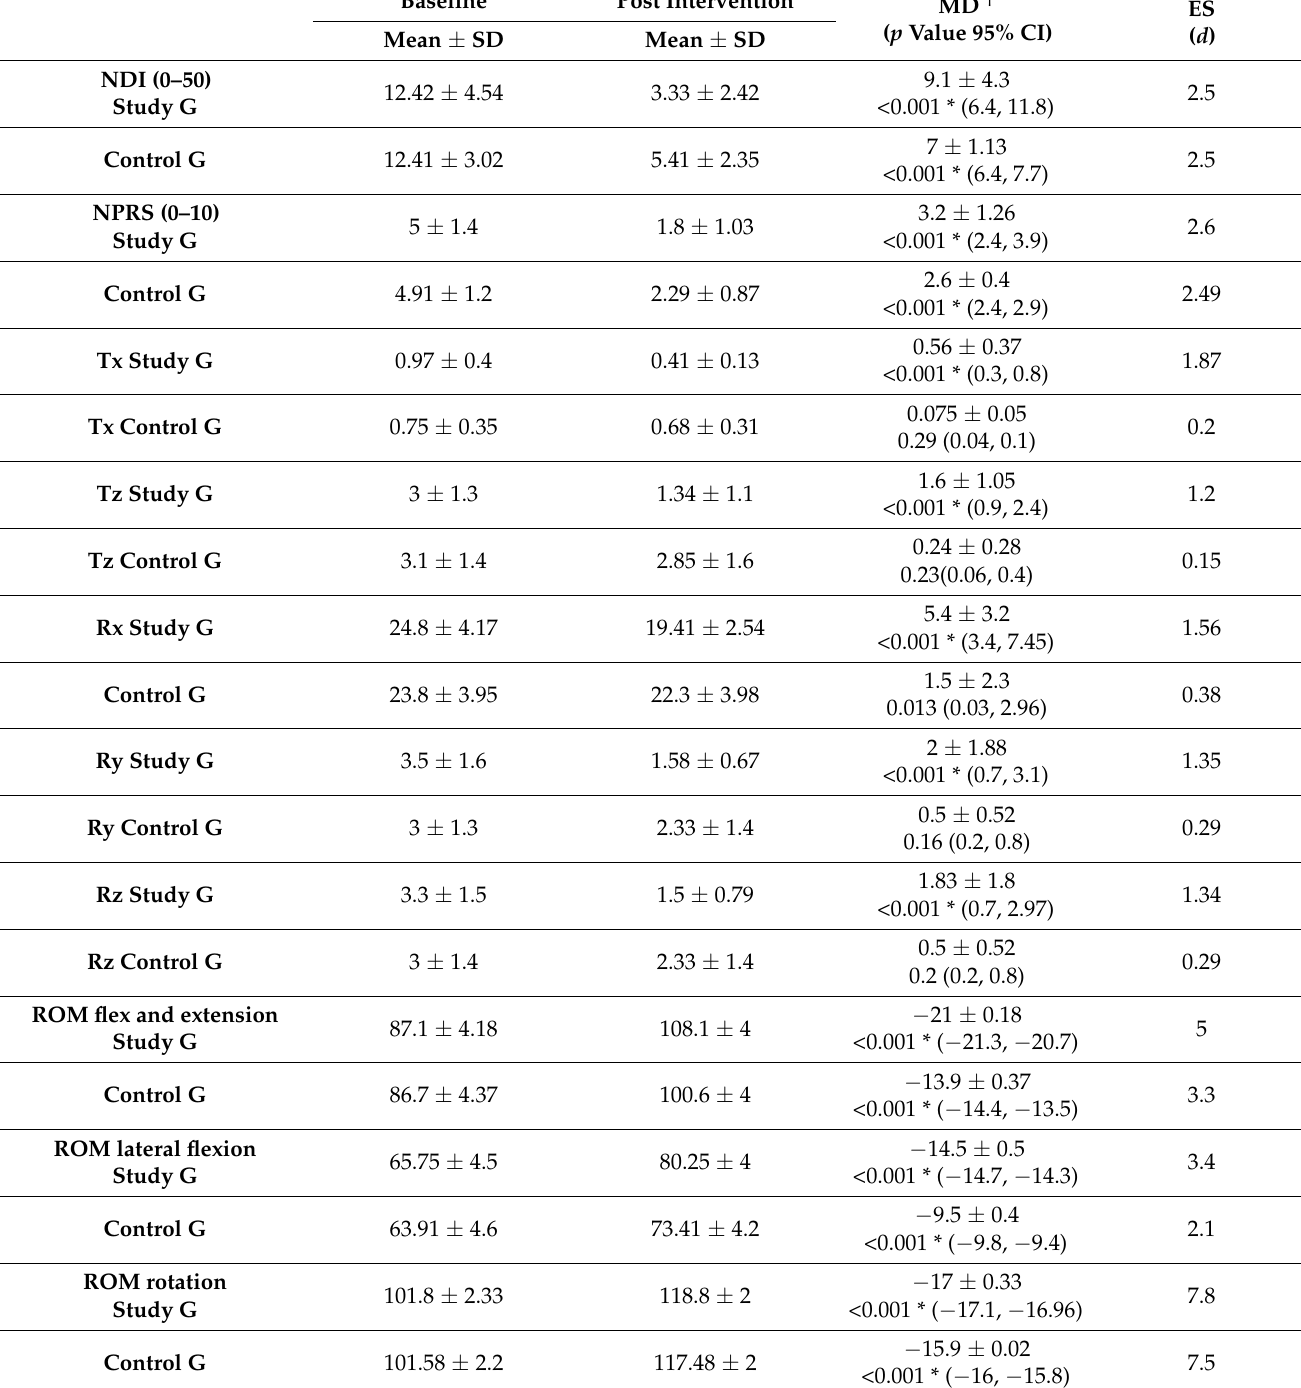
Table 5. Within-group change in secondary outcome measures for each group. Postural translations (Tx and Tz) are measured in centimeters, postural rotations (Rx, Ry, Rz), and ranges of motion (ROM) are measured in degrees. The mean difference (MD) is the difference between the baseline and after-treatment values. A negative value for the change (MD) in range of motion indicates an increase in the overall motion for the